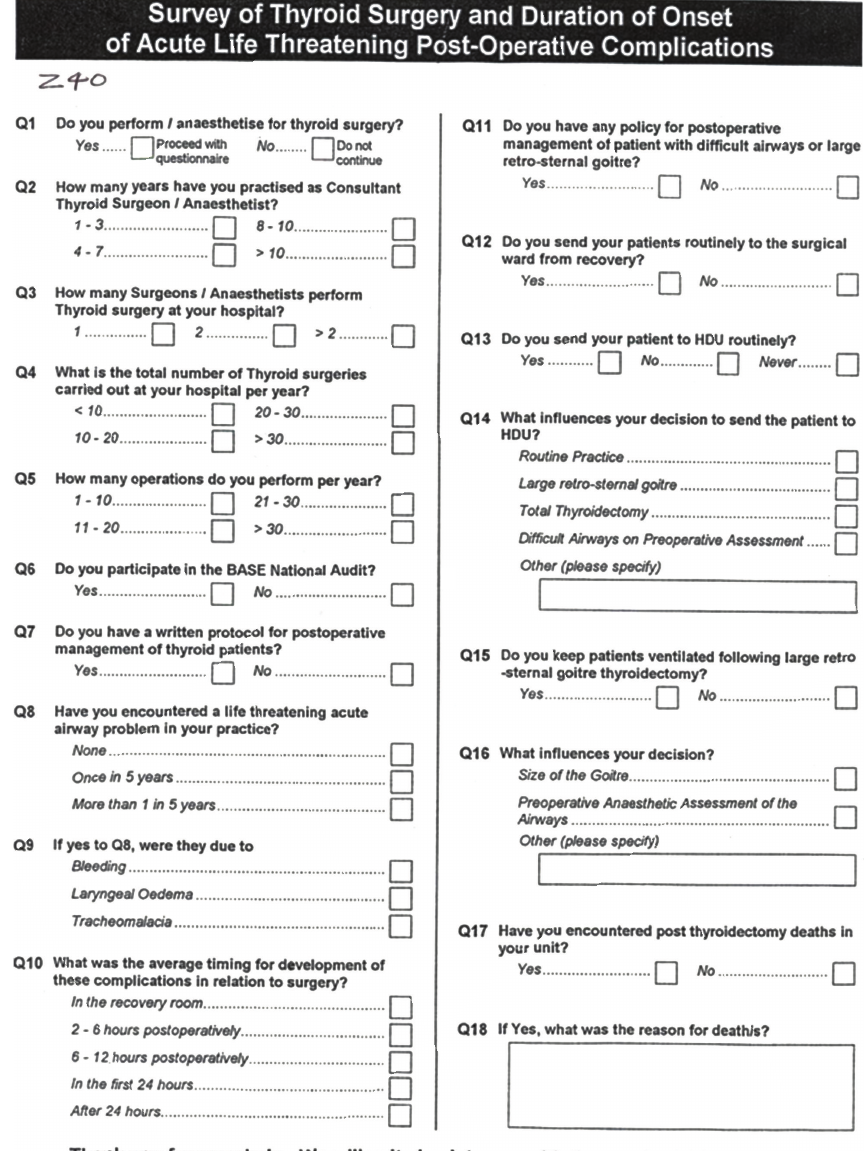
Figure 1: Scanned image of questionnaire